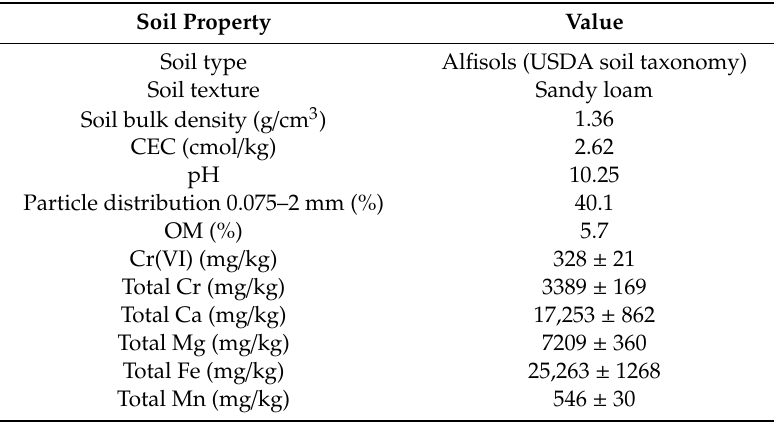
Table 1. Physical and chemical properties of the soil.